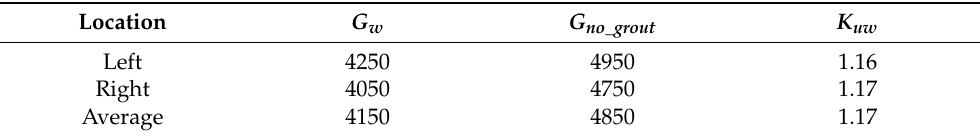
Table 6. Gray value numbers and K ratios of Figure 36. 750 mm by 3.95 MeV, grout is not filled.